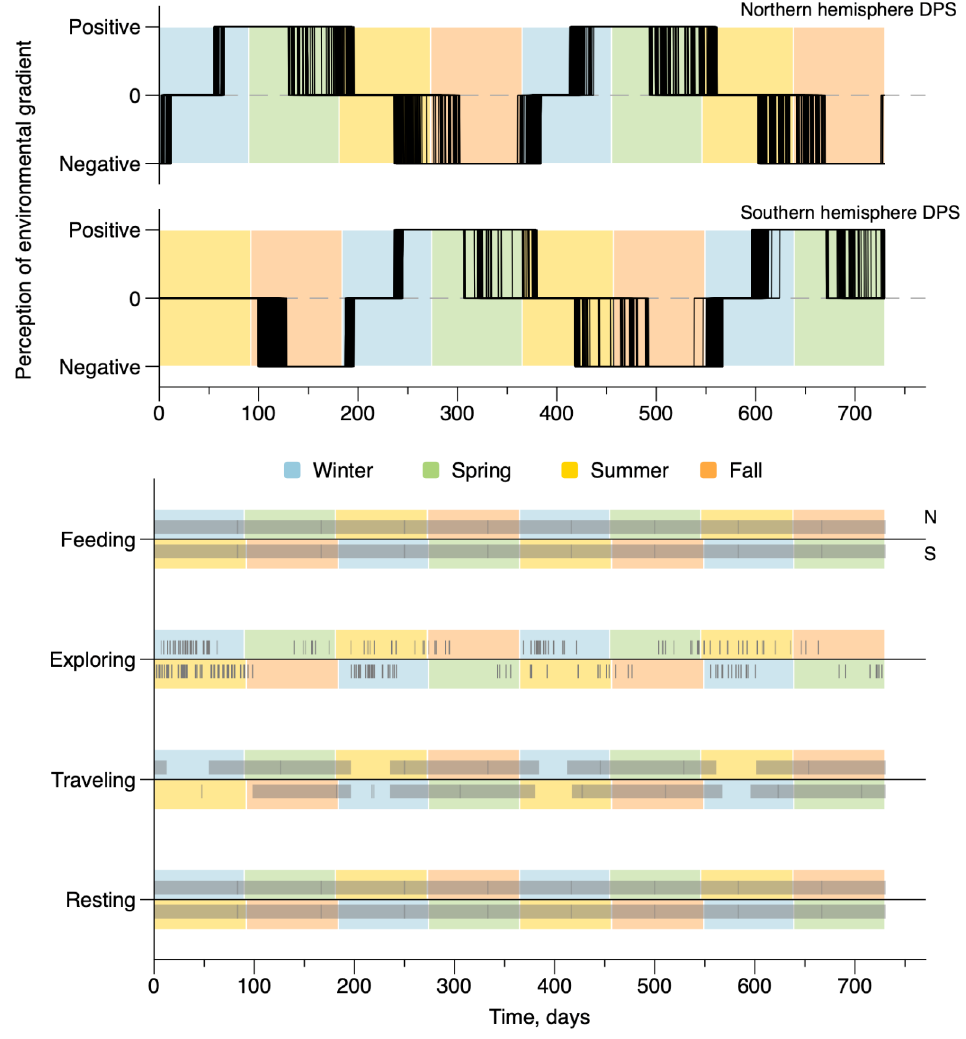
Figure 5. Time variations of the activity and behavior of whales in an actual Earth topography configuration. The upper figure represents the realized perception of the environmental gradient defining the activity, superimposed on the seasonal cycle at mid-latitudes. When the perception was positive, whales migrated from low latitudes toward the poles, when the perception was negative, whales migrated from high latitudes toward the equator. The lower figure shows the four behavior occurrences (black lines) superimposed on a seasonal cycle at